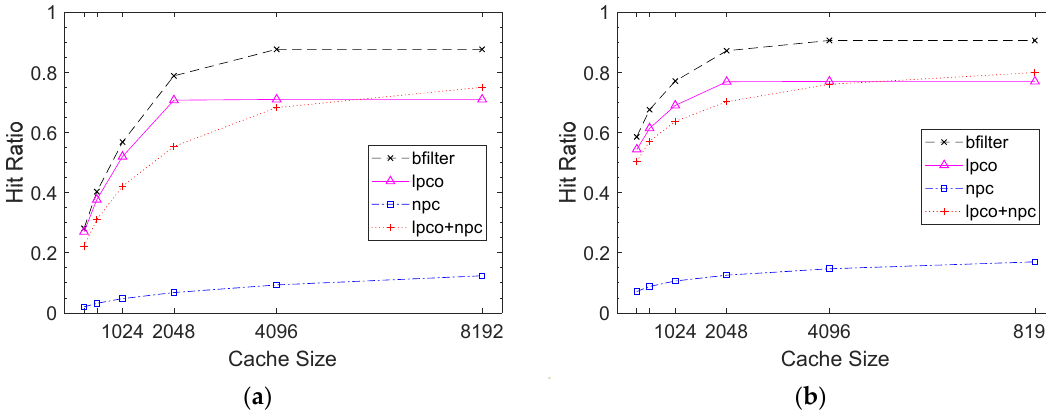
Figure 9. Comparison of caching schemes for cache hit ratio in the traces with ( a ) α = 0.7, and ( b ) α = 1.0.